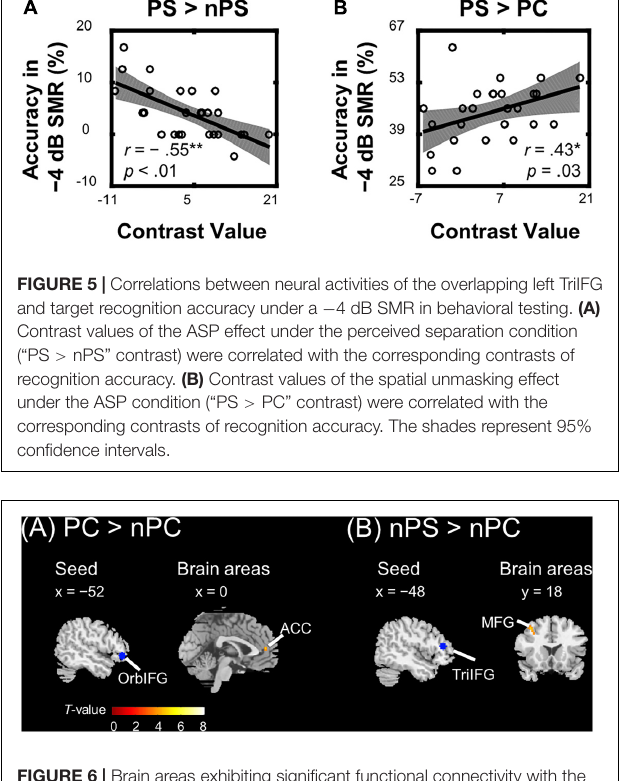
FIGURE 6 | Brain areas exhibiting significant functional connectivity with the left IFG by the ASP effect and spatial unmasking effect. (A) The ASP effect under the perceived co-location condition (“PC > nPC” contrast) enhanced the functional connectivity between the left OrbIFG and the bilateral ACC. (B) The spatial unmasking effect under the ANSP condition (“nPS > nPC” contrast) enhanced the functional connectivity between the left TriIFG and the left MFG. All peaks survived an uncorrected threshold of p < 0.001 at the voxel level ( t > 3.43), and each cluster consisted of more than 20 contiguous voxels. The positive value of x (the coronal axis) denotes the right hemisphere. Negative values of the x axis (the coronal axis) denote the left hemisphere. Positive values of y (the sagittal axis) denote the front. The blue areas are seed